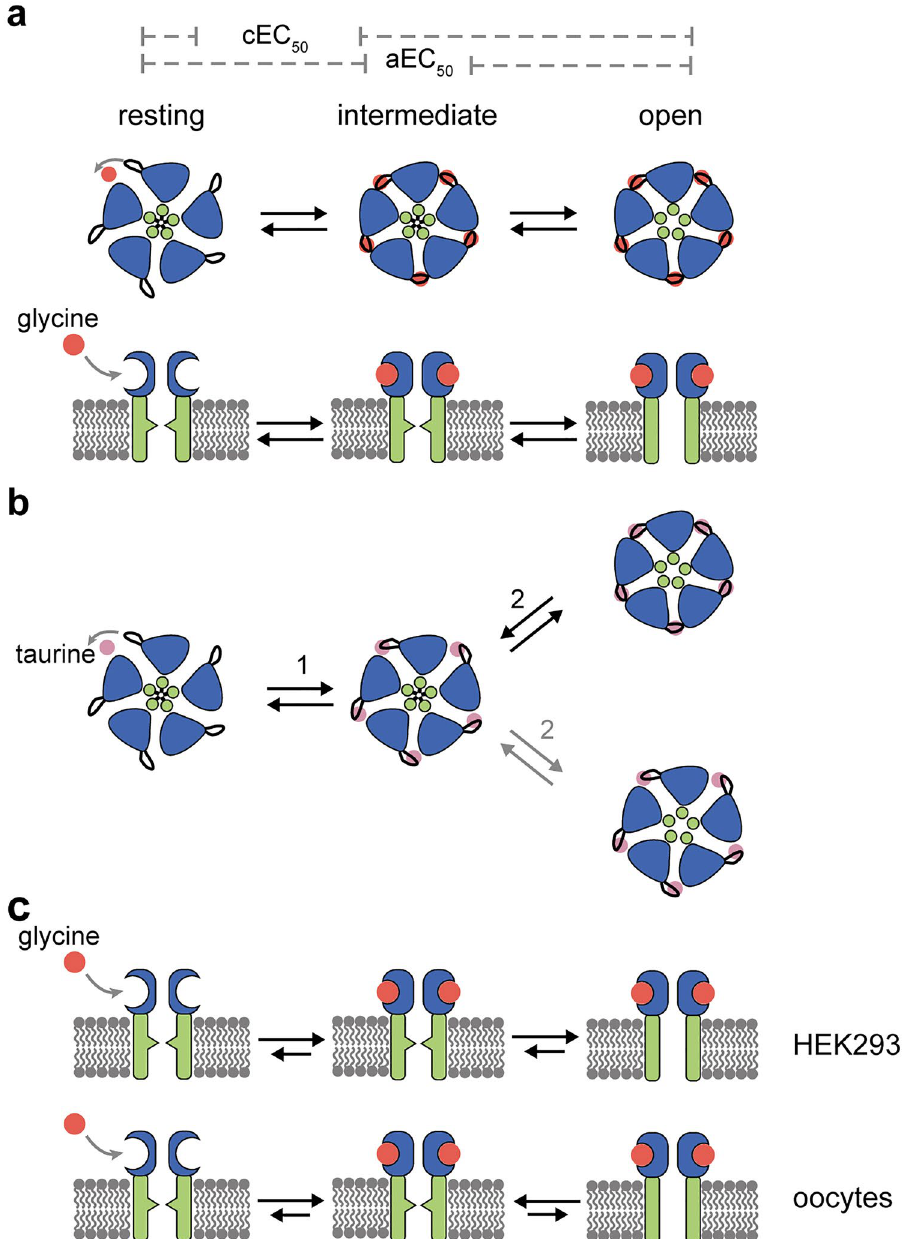
Figure 5. Schematic model of the activation mechanism of GlyRs for full and partial agonists. ( a ) The general activation mechanism of GlyRs includes at least three conformational states, whereby two conformations adopting a contracted ligand-bound ECD. Binding of a full agonist (red dot) induced an ECD closure of the resting receptor, while the ion channel is still shut (intermediate state). This ECD closure finally opens the ion channel and activates the receptor (open state). The ability of an agonist to change the conformation within the ECD (cEC 50 ) was measured by MST, while the general ability to activate the receptor (aEC 50 ) was determined by electrophysiological methods. ( b ) Binding of a partial agonist (purple) initiate an incomplete closure of the ECD (1). The receptor is either activated by a further ECD closure (2, grey) that leads to an ion channel opening (open state) or can directly open with a less contracted ECD (2, black). ( c ) GlyR activation in HEK293 cells and oocytes. Glycine binding to GlyRs in HEK293 cells is characterized by a contraction of the ECD and a rapid channel opening, reflected by similar cEC 50 and aEC 50 values. Binding of glycine to GlyRs in oocytes is also characterized by an efficient reorientation of the ECD with an impaired channel opening, possibly stabilizing an intermediate state with a contracted ECD and a closed channel pore. Figure was drawn using Abobe Illustrator CC version 24.3 (https ://www.adobe .com/kr/produ cts/illus trato